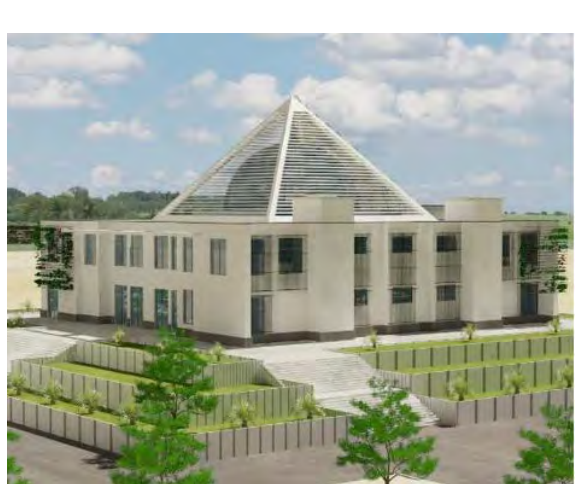
Figure 12. D-North west shot